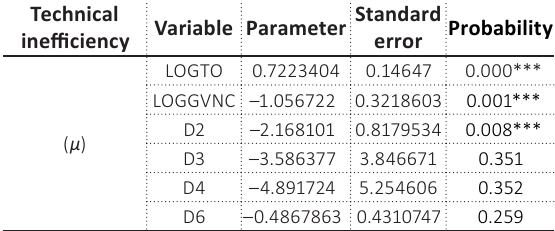
Table 6. Determinants of technical